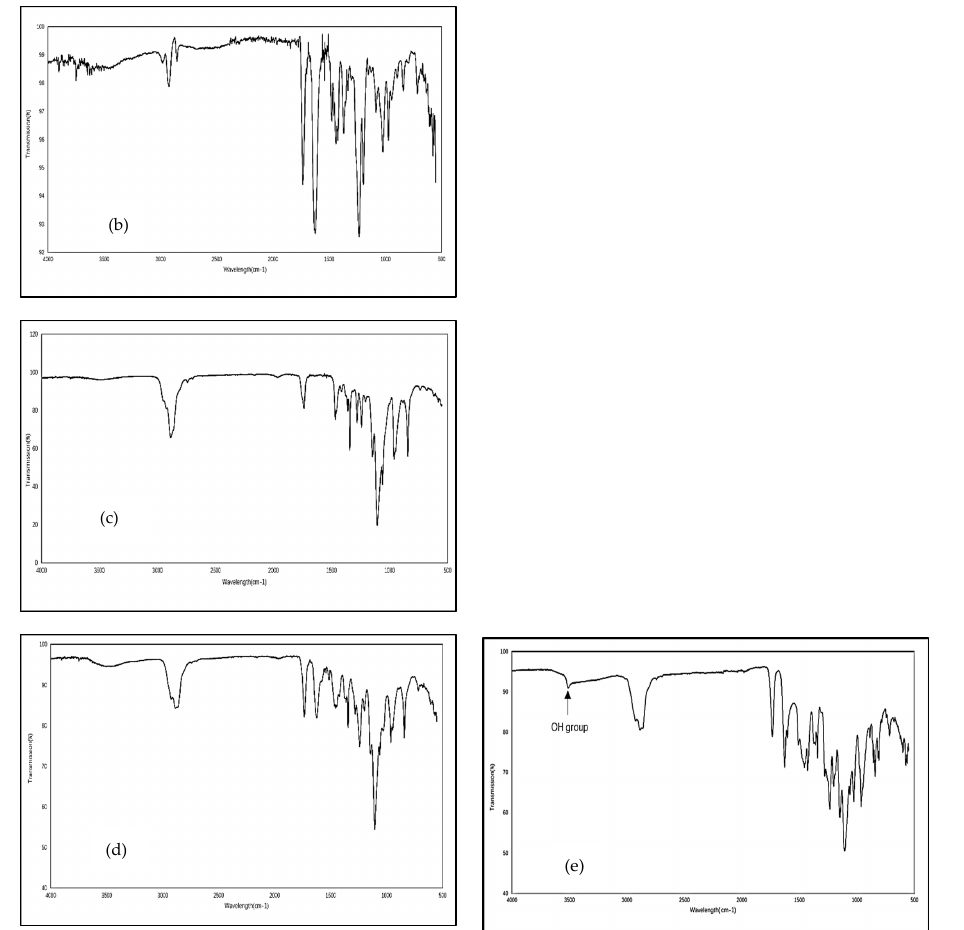
Figure 3. FTIR spectra of ( a ) commercial curcumin, ( b ) Soluplus ® , ( c ) Vitamin E TPGs, ( d ) Formulation A and ( e ) physical mixture of Formulation A (curcumin:Soluplus:Vitamin E TPGs 1:10:10).